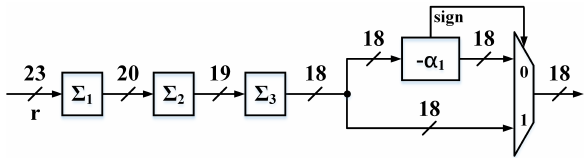
Figure 14: Block graph of the modular reduction module for modulus ( q − 1) /